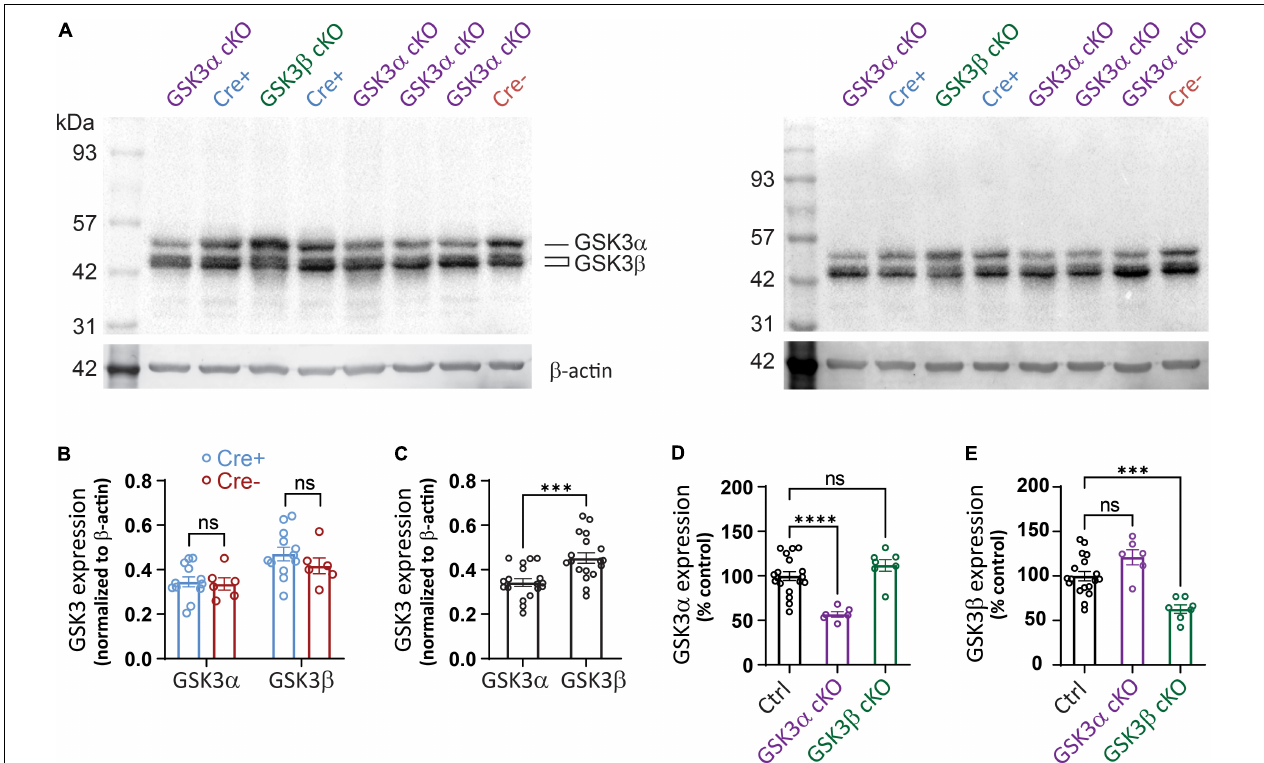
FIGURE 2 | Western blot detection of targeted protein reduction in GSK3 α or GSK3 β cKO. (A) Western blot sample results using hippocampal lysates from tissue studied in Figures 3 – 5 . Lysates from GSK3 α cKO, GSK3 β cKO, Cre+, and Cre- were loaded by the experimenter blinded to genotype and then the data was averaged from 2 to 4 technical replicates per slice. (A) Shows two of the technical replicates for samples obtained from the same 8 mice. Blots were probed initially for GSK3 and subsequently for β -actin. (B) Similar levels of expression of GSK3 α and GSK3 β when Cre+ and Cre- mice are compared. Note that both isoforms of GSK3 β were detected and included in the analysis. (C) Quantification shows a higher signal for GSK3 β compared to GSK3 α for pooled control samples. (D) Reduced GSK3 α expression in the GSK3 α cKOs compared to control (Ctrl) samples, with no significant change in level of the GSK3 β paralog. (E) Reduced GSK3 β expression in the GSK3 β cKOs compared to control (Ctrl) samples, which was associated with no significant change in level of the GSK3 α paralog. Data for (B) were analyzed with two-way ANOVA; effect of Cre+ vs. Cre- [ F (1,32) = 1.119, p = 0.2981; effect of GSK3 α vs. GSK3 β : F (1,32) = 12.35, p = 0.013; effect of interaction: F (1,32) = 0.563, p = 0.4584, N = 18.] Data shown in (C–E) were analyzed with an unpaired Student t -test. *** p < 0.001, **** p < 0.0001, ns, not significantly different. N = 18 for control, N = 6 for GSK3 α cKO, N = 7 for GSK3 β